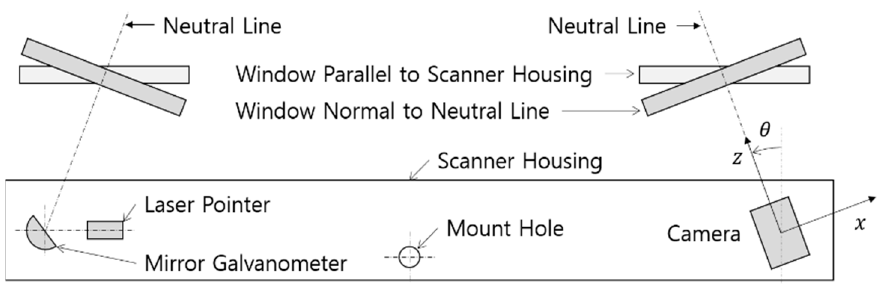
Figure 2. Optical system configuration of industrial 3D scanner.